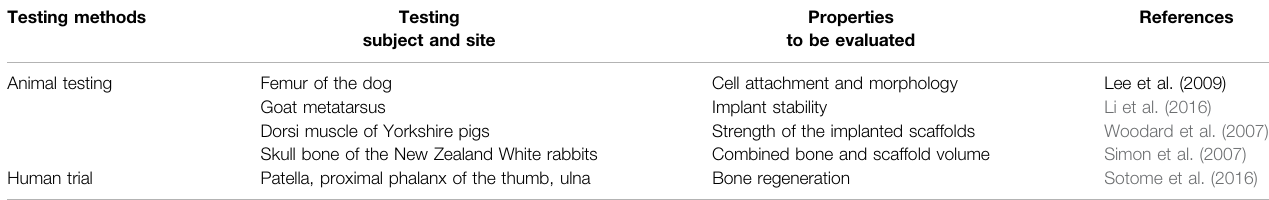
TABLE 8 | Summary of the in vivo testing